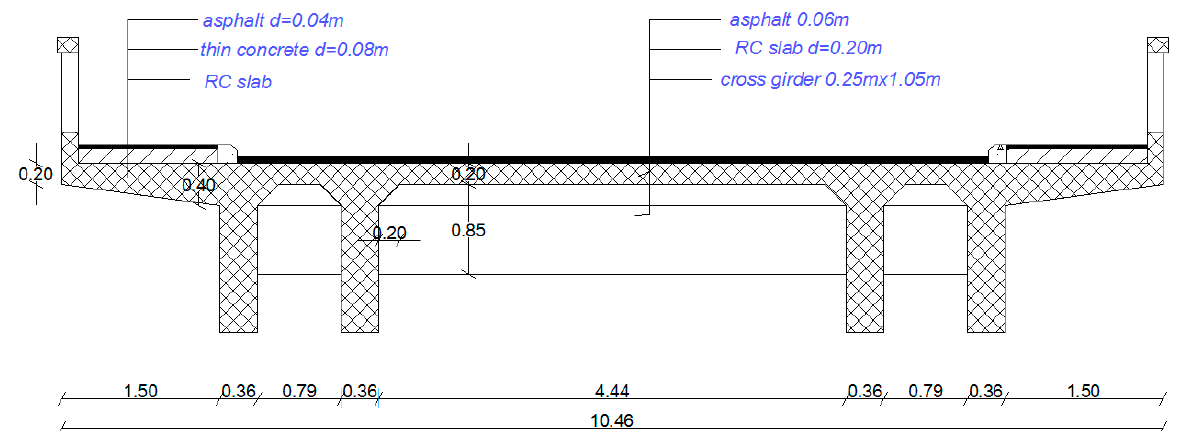
Figure 3. Longitudinal section of the bridge.